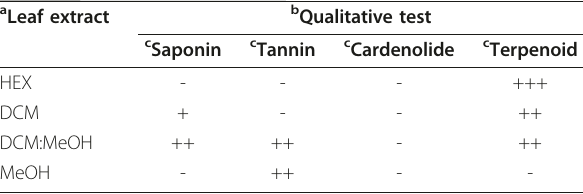
Table 4 Phytochemical screening of leaf extracts